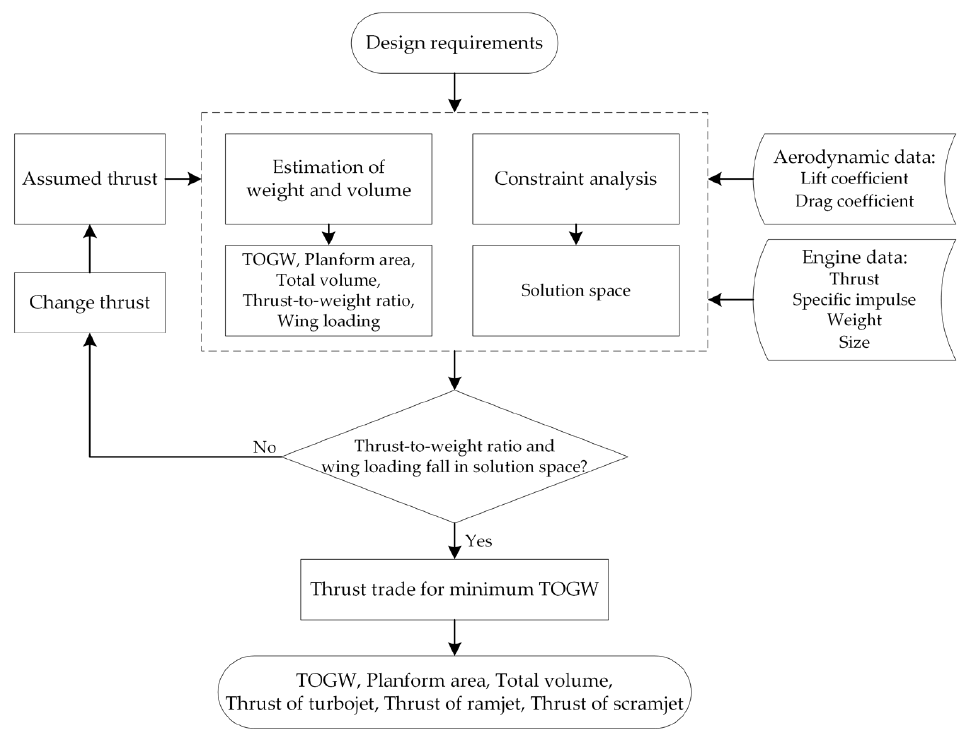
Figure 5. Procedure of initial sizing.